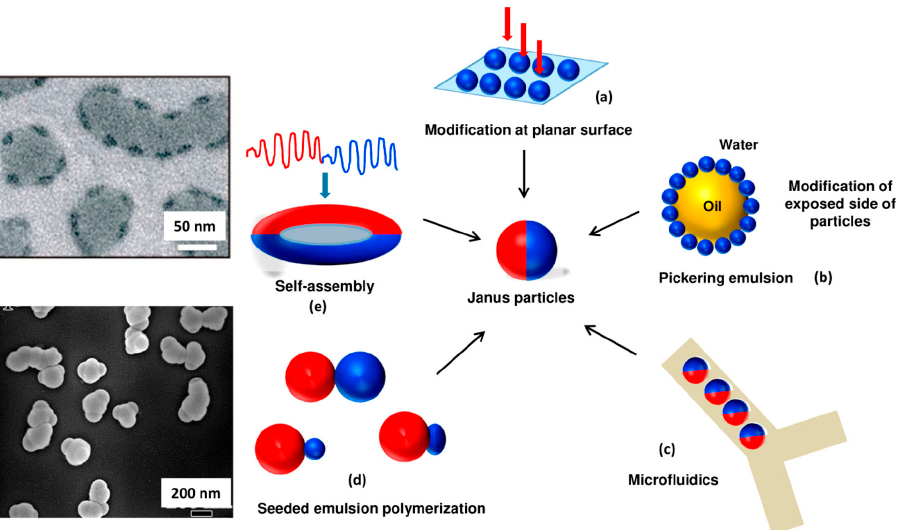
Figure 5. Overview of production approaches of Janus particles. ( a ) Modification and fixation on solid substrates, ( b ) Pickering emulsion method, ( c ) Microfluidic method, ( d ) Seeded emulsion polymerization approach, ( e ) Self-assembly approach. Reproduced with permission from Agarwal and Agarwal (2019), © American Chemical Society, 2019 [53].